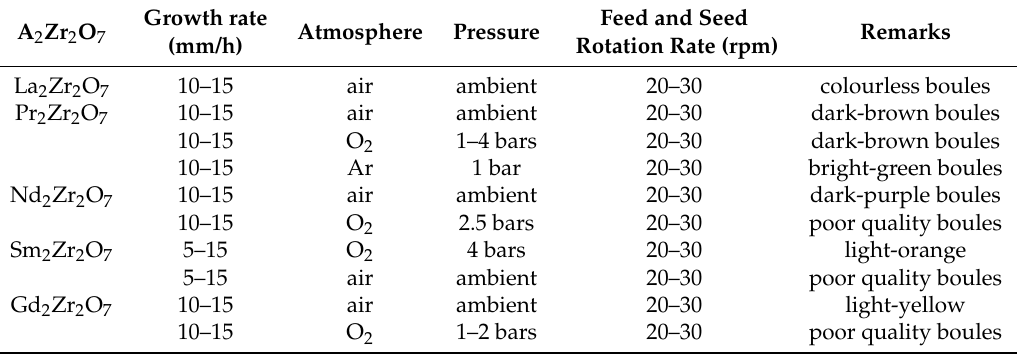
Table 4. Summary of the conditions used for the growth of A 2 Zr 2 O 7 crystals. All the boules grown were transparent to light.